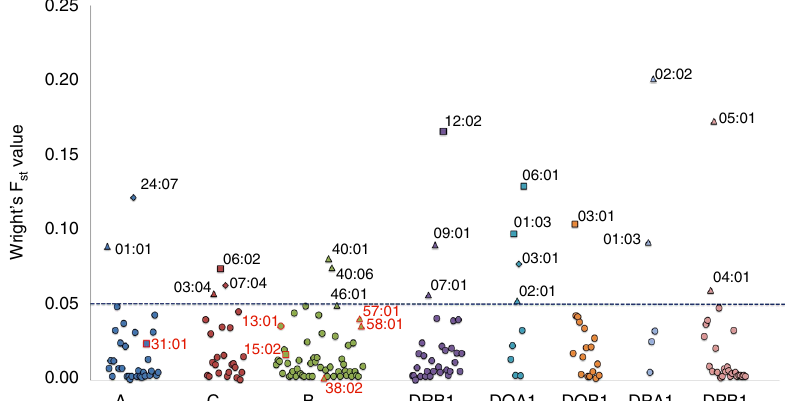
Fig. 2 Distribution of the Wright F ST value across three ethnic groups at the eight HLA loci. The distribution of the Wright F ST value across three populations at the eight HLA loci. The alleles shown in the plot are the top three F ST alleles at each HLA loci. The triangular shape indicates the HLA alleles, where the F ST values are driven by differences between Chinese and Indians. The diamond shape indicates the HLA alleles, where the F ST values are driven by the differences between Chinese and Malays. The square shape indicates the HLA alleles, where the F ST values are driven by the differences between Malays and Indians. Shapes with red color outline are representing drug-associated HLA alleles 41 (Table 3)